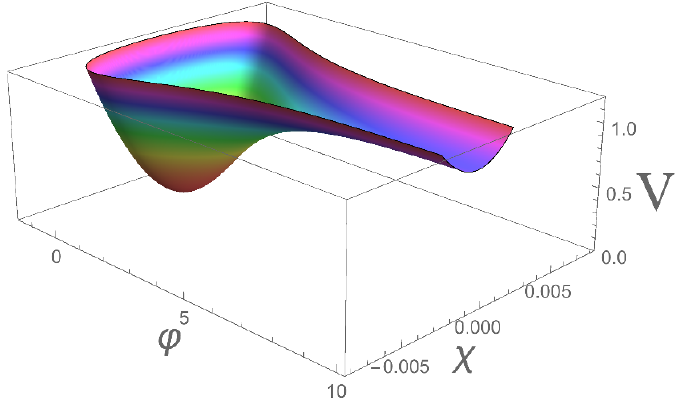
Figure 3 . E-model version of the (cid:12)bre in(cid:13)ation